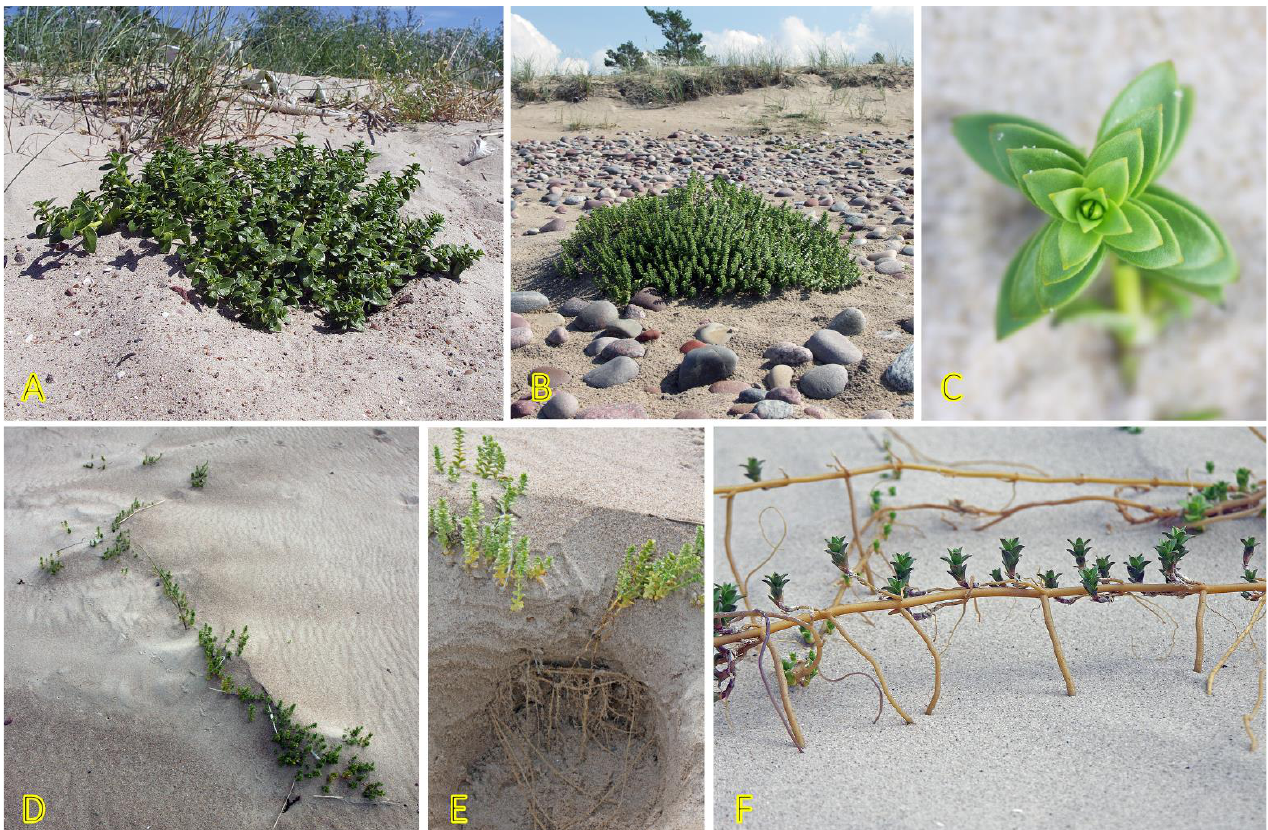
Figure 12. Honckenya peploides plants on undisturbed dunes in Kuiviži, Latvia ( A ), on a gravel–pebble beach in Užava, Latvia ( B ), a symmetric shoot ( C ), foraging genet on embryonic dunes in Carnikava, Latvia ( D ), excavated rhizomes in Carnikava, Latvia ( E ), genet on an eroded sandy beach in Buļļusala, Rīga, Latvia ( F ).